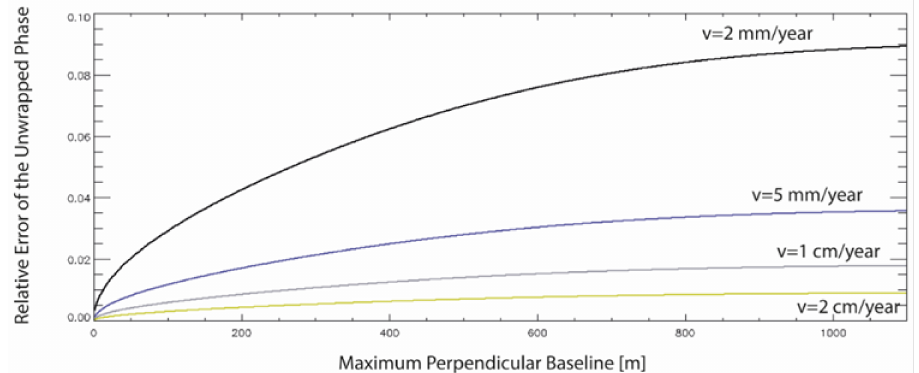
Figure 7. The plot of the unwrapped phase’s relative errors vs. the selected maximum allowed perpendicular baseline of the SB interferograms, for different values of the ground mean displacement rate of the imaged